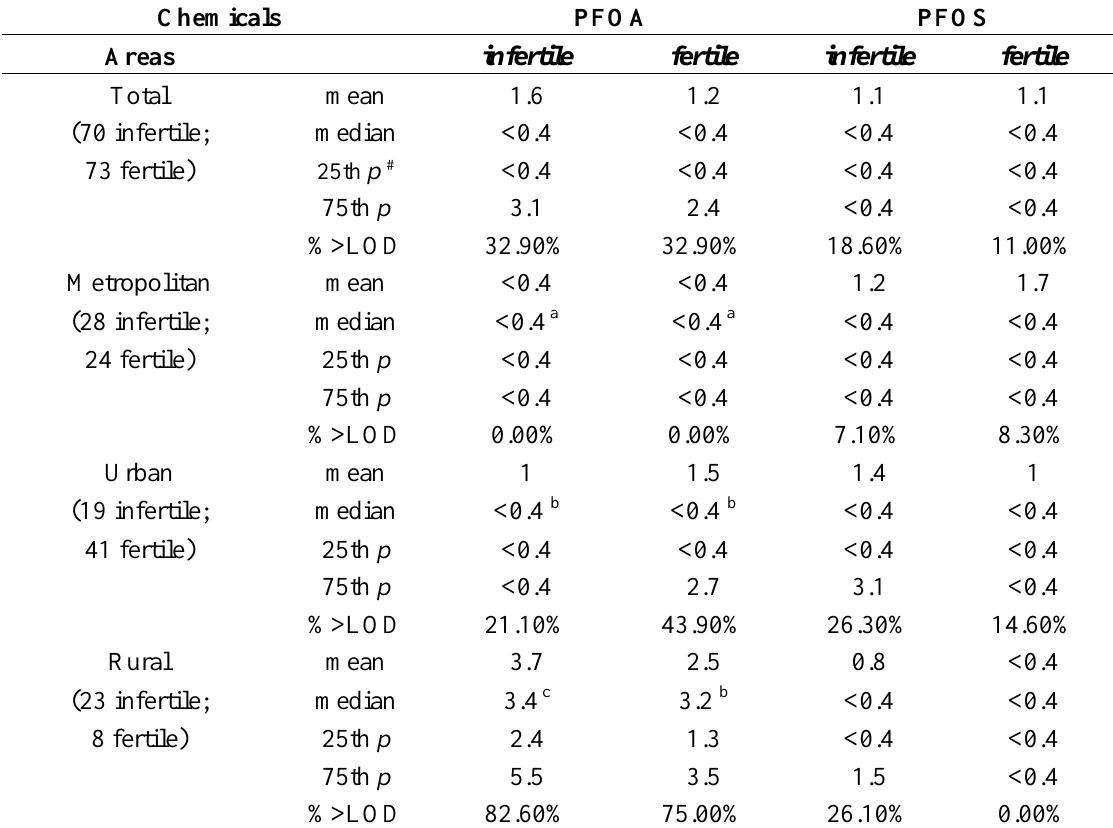
Table 4. Analytical values of PFOS and PFOA (ng/mL semen) in enrolled men grouped by area of residence and subject